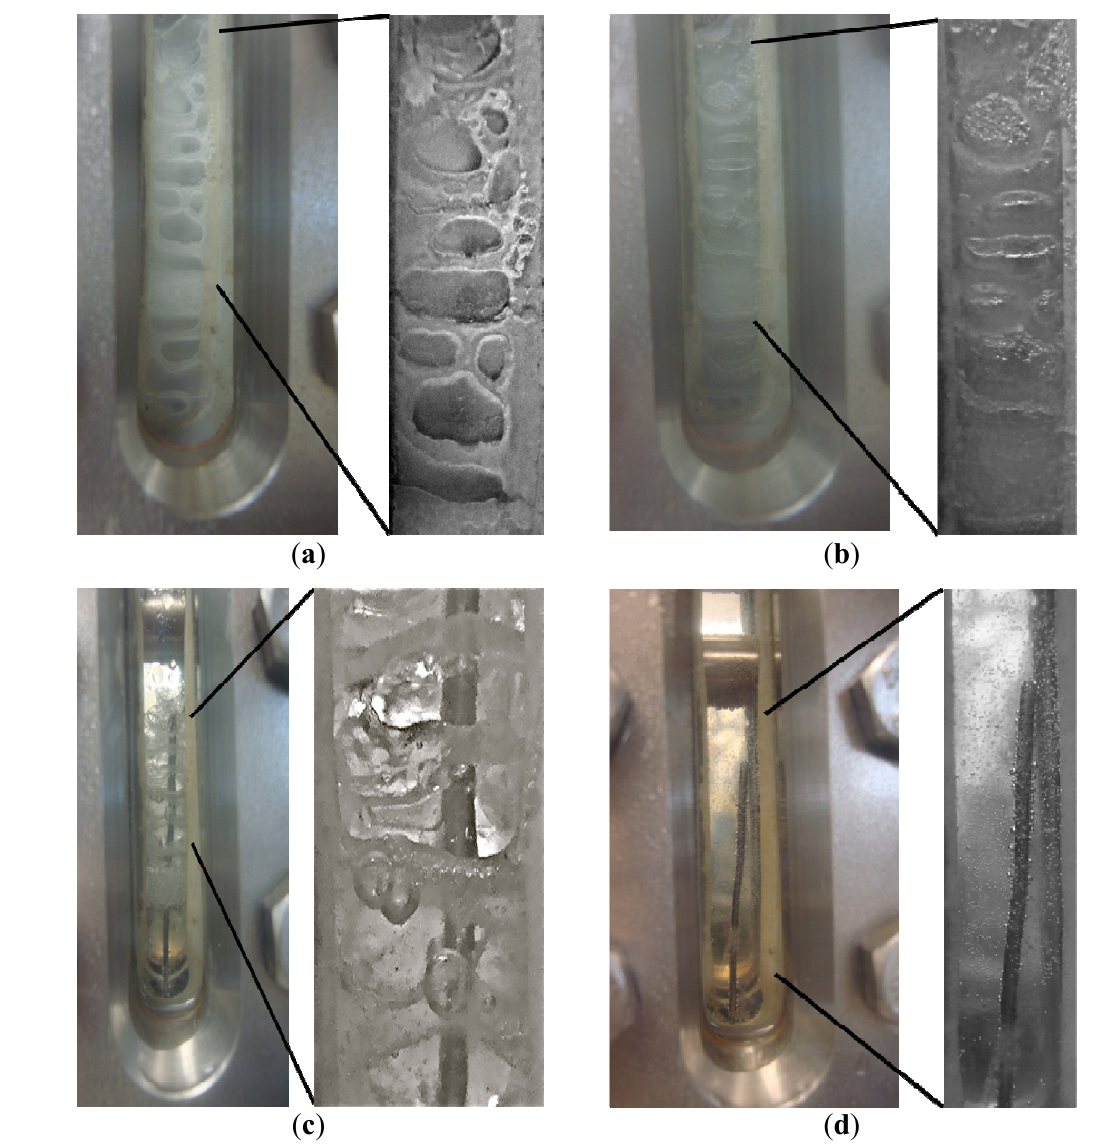
-CO hydrate phase at the end of 4 2